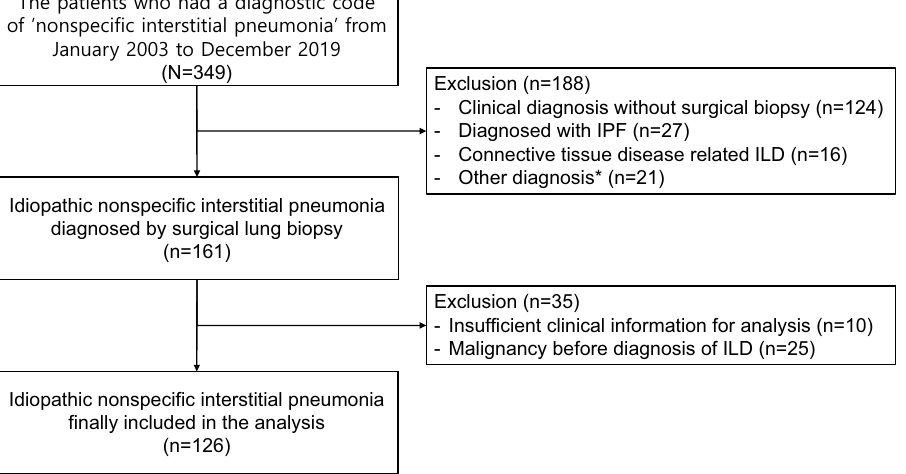
Figure 3. Flow diagram of the study population. * Other diagnoses included cryptogenic organizing pneumonia, chronic hypersensitivity pneumonitis, pleuroparenchymal fibroelastosis, and unclassifiable